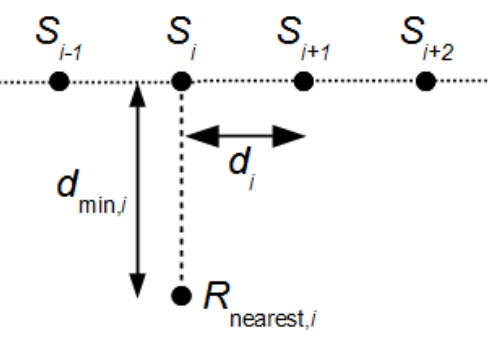
Figure 1. Breakdown of a line source into a series of point